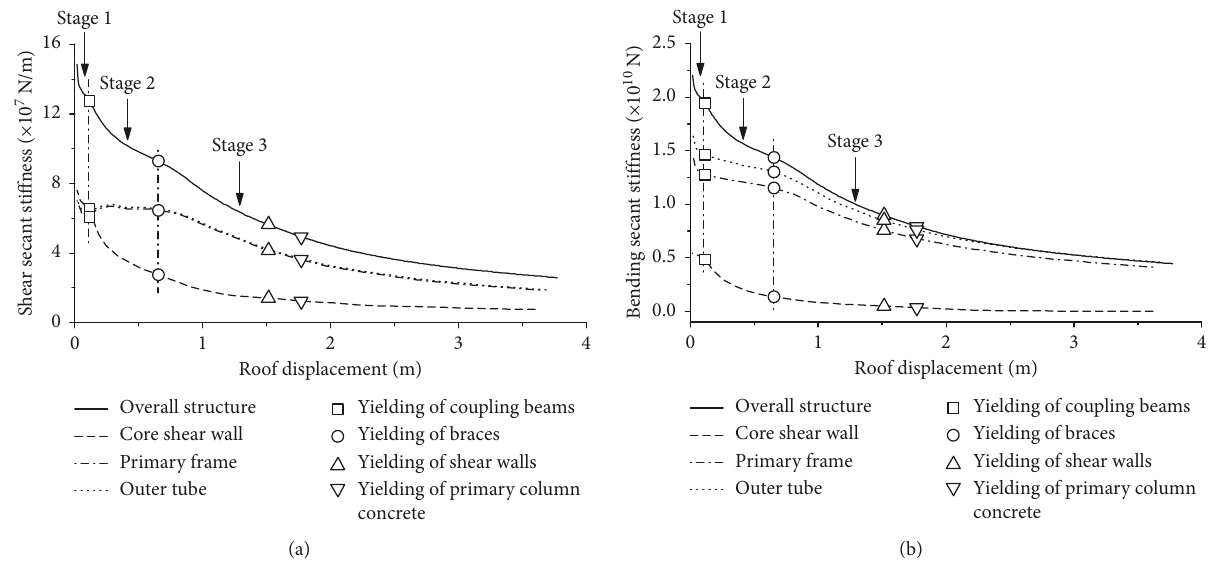
Figure 17: Stiffness degradation process of model 5MBC: (a) shear stiffness degradation; (b) bending stiffness